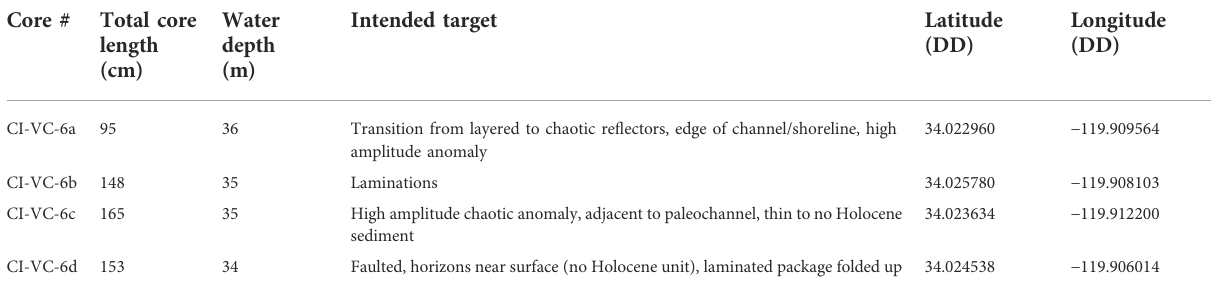
TABLE 1 Intended targets identi fi ed in the sonar data used to position four cores within Box 6.